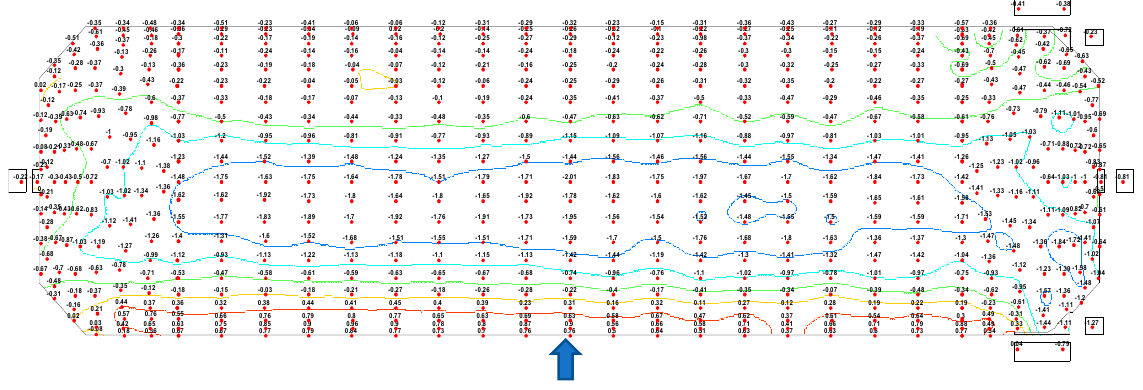
Figure 7. Average wind pressure coefficient of film surface at an 180° wind angle.